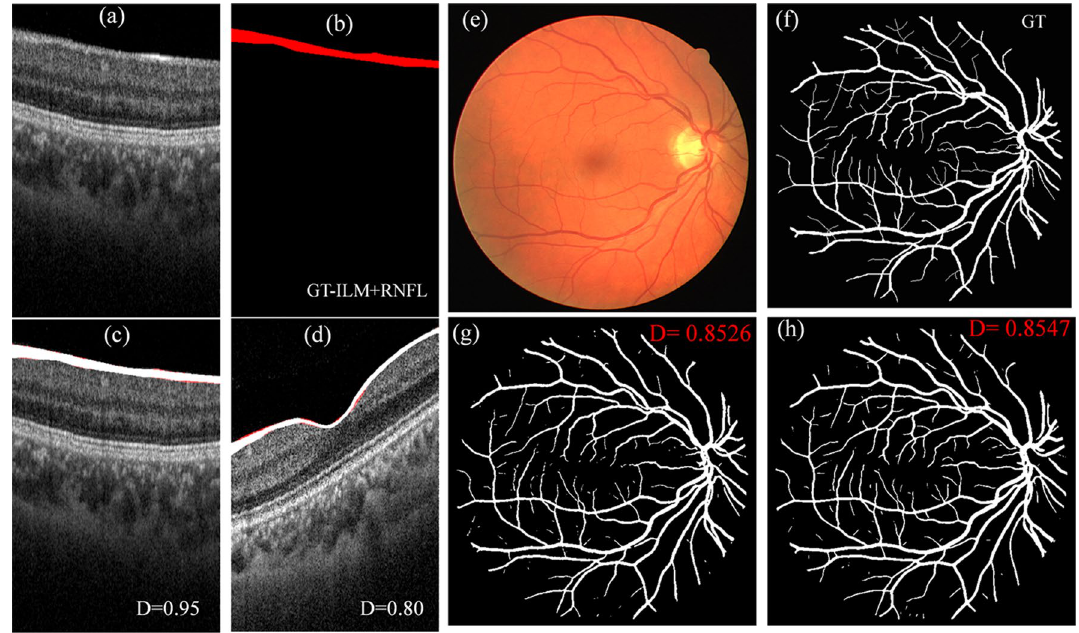
Figure 10. Application of lightweight DL model in segmentation of other ophthalmic images. ( a – d ) are the examples of segmentation of ILM + RNFL layer in OCT-B scan, (a) is the original B-scan from the testing dataset which has highest D, ( b ) is the corresponding manually segmented GT image, ( c ) is the segmented image overlapped on ( a ) with GT, and ( d ) is the segmented image from a testing dataset, which has lowest D. ( e – h ) are the examples of retinal vessel segmentation on a fundus photo from DRIVE dataset. ( e ) fundus photo, ( f ) manual segmentation (from grader-2 in dataset), ( g ) segmented with Unet_AB, and ( h ) with LWBNA_Unet